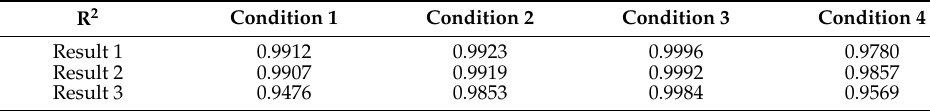
Figure 10. Three results’ curves fitting parameter R 2 in four conditions. Table 4. The fitting parameter R 2 in four conditions. R 2